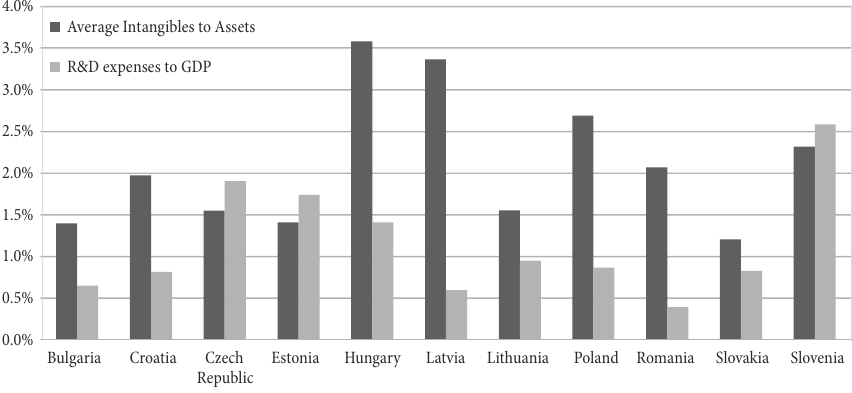
Fig. 1. Average intangibles in % of total assets and R&D expenses to GDP by CEE countries (Fiscal Year 2013) Source: